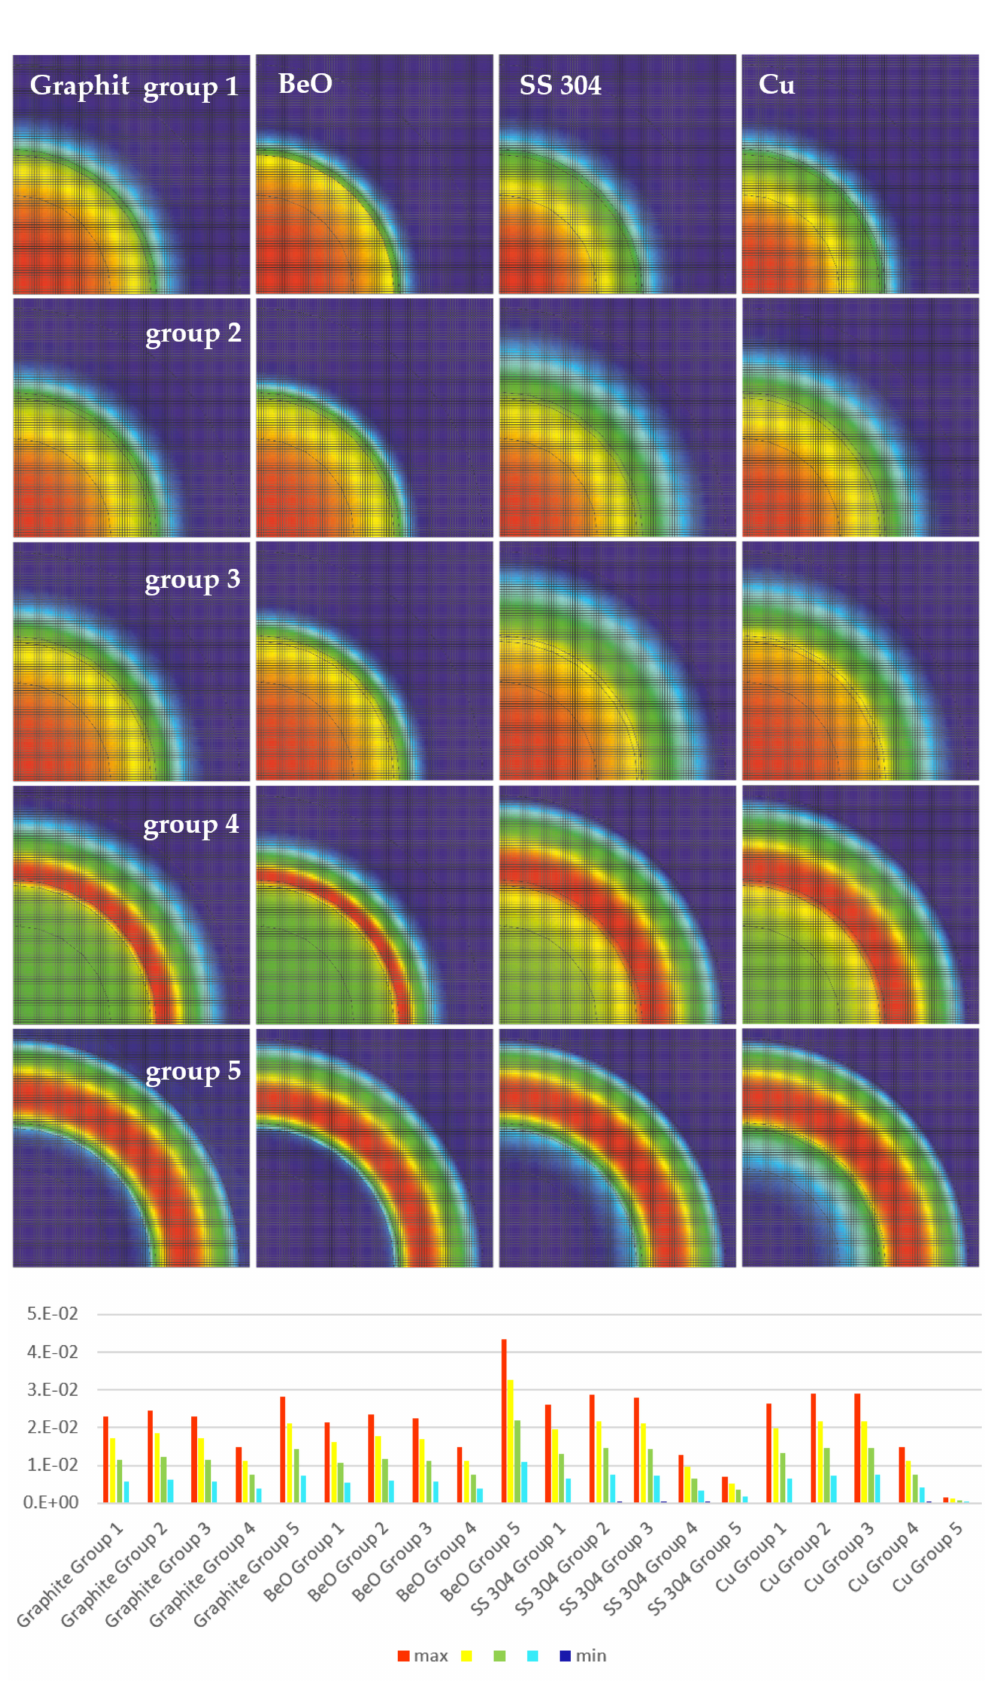
Figure 15. Groupwise 2D spatial neutron flux distributions in the core for four different strongly reflecting